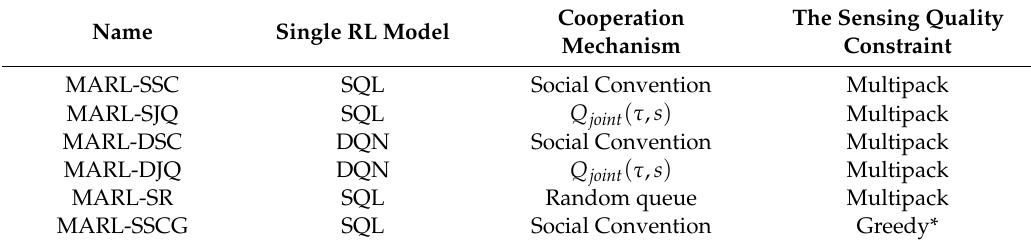
Table 3. Experimental baselines.